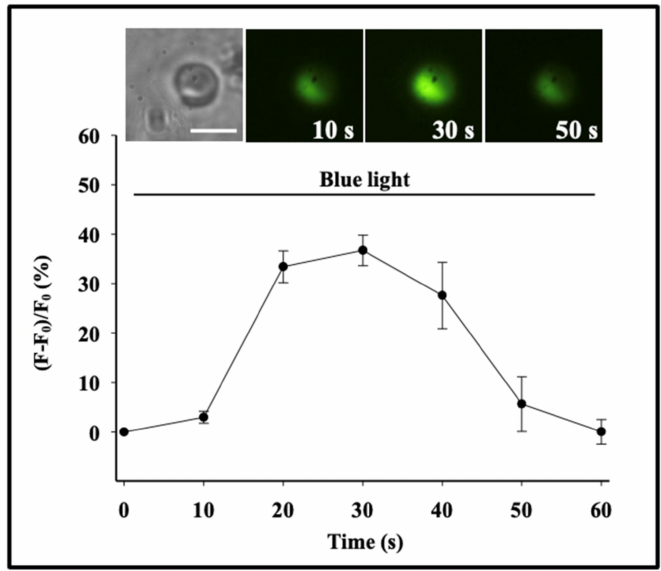
Figure 5. A characteristic transient increase of intracellular [Ca 2+ ] C takes place following stimulation in Phaeocystis [20]. We studied Ca 2+ -signaling in photostimulated Phaeocystis by using the membrane- permeant fluorescent Ca 2+ probe Fluo 4-AM. As shown here, exposure of Phaeocystis to blue light stimulation ( λ = 450–490 nm) results in a transient increase of intracellular [Ca 2+ ] C reported by a corresponding increase of fluorescence expressed as the ratio of emission before and after stimula- tion. This typical increase of [Ca 2+ ] C was consistently followed by exocytosis and release of MBP stored in the secretory granule. Each point corresponds to the mean ± SEM of nine measurements. Bar = 10 µ